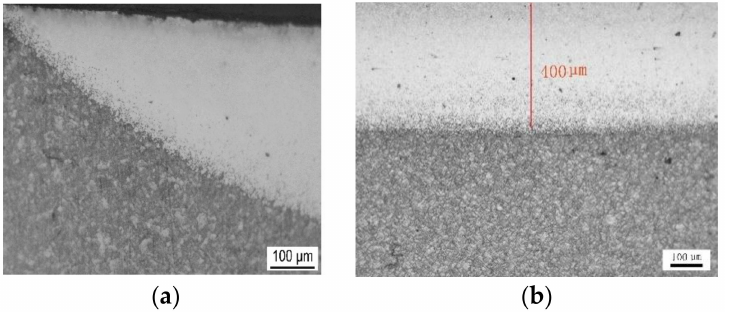
Figure 5. Metallographic cross-section of laser hardened layer with a scanning speed of 800 mm/min; ( a ) crescent shape on left side and ( b ) thickness at center of hardened area.